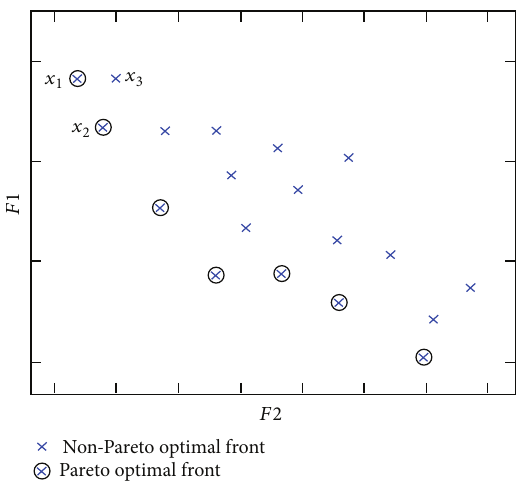
Figure 2: Pareto and non-Pareto optimal fronts for the multiobjec- tive function CBM asg